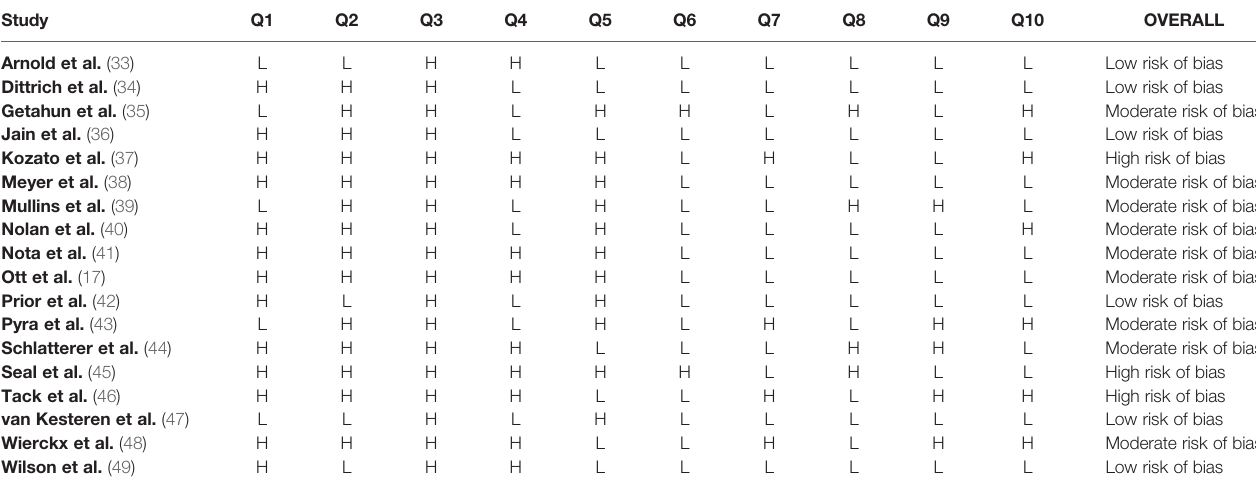
TABLE 2 | Quality assessment of the included